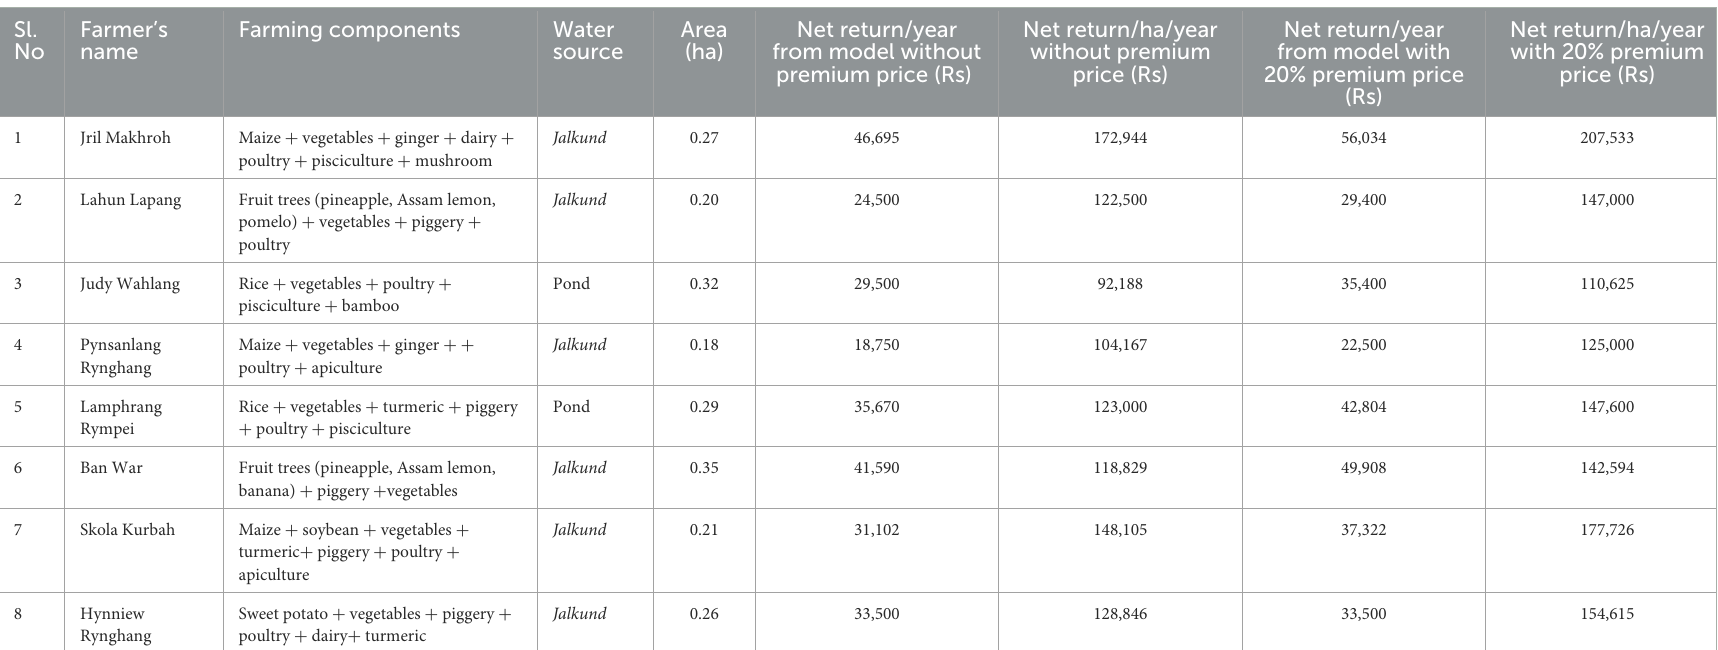
TABLE 1 Farmers who adopted the IOFS model in Meghalaya, India and their economic return (average of 5 years). Sl.